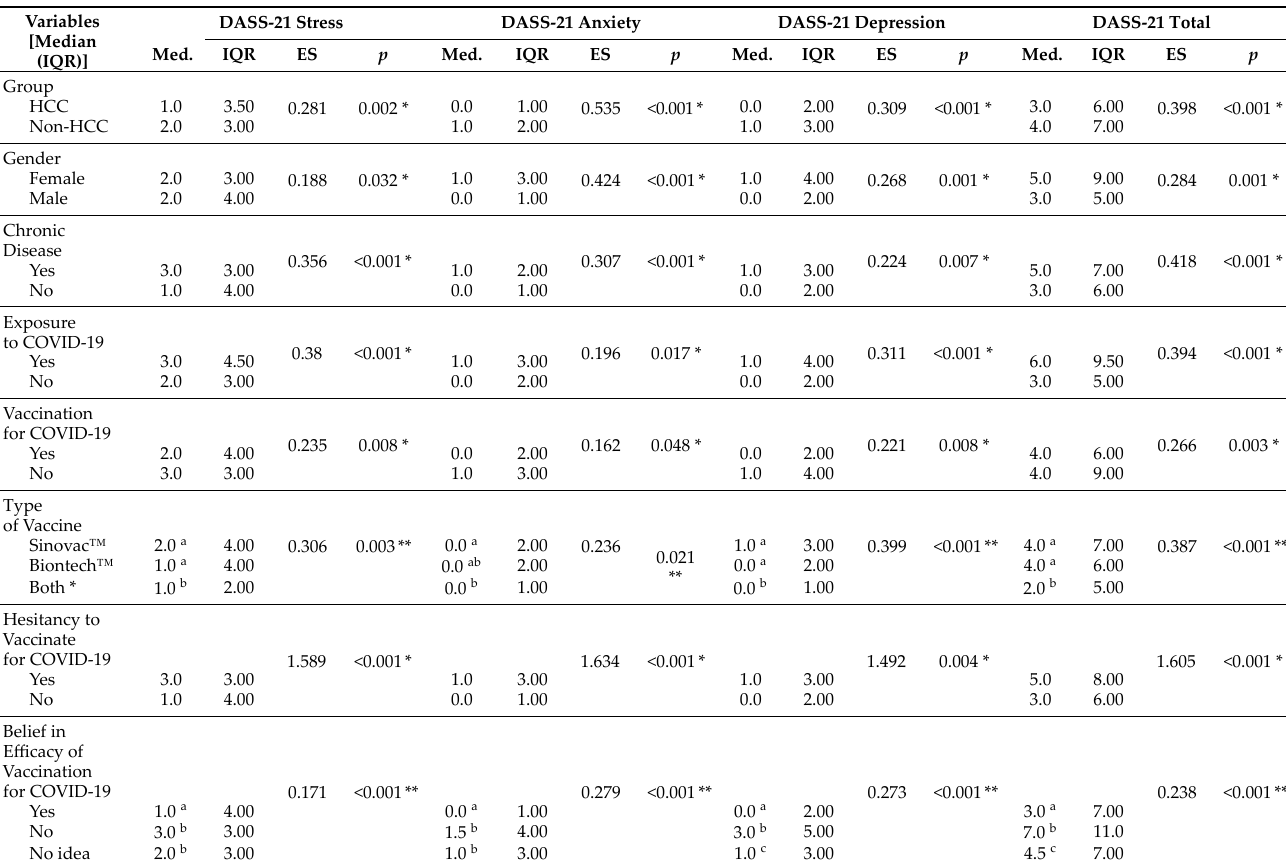
Table 3. Comparison of the independent variables according to the subdimension and total scores of the DASS‑21